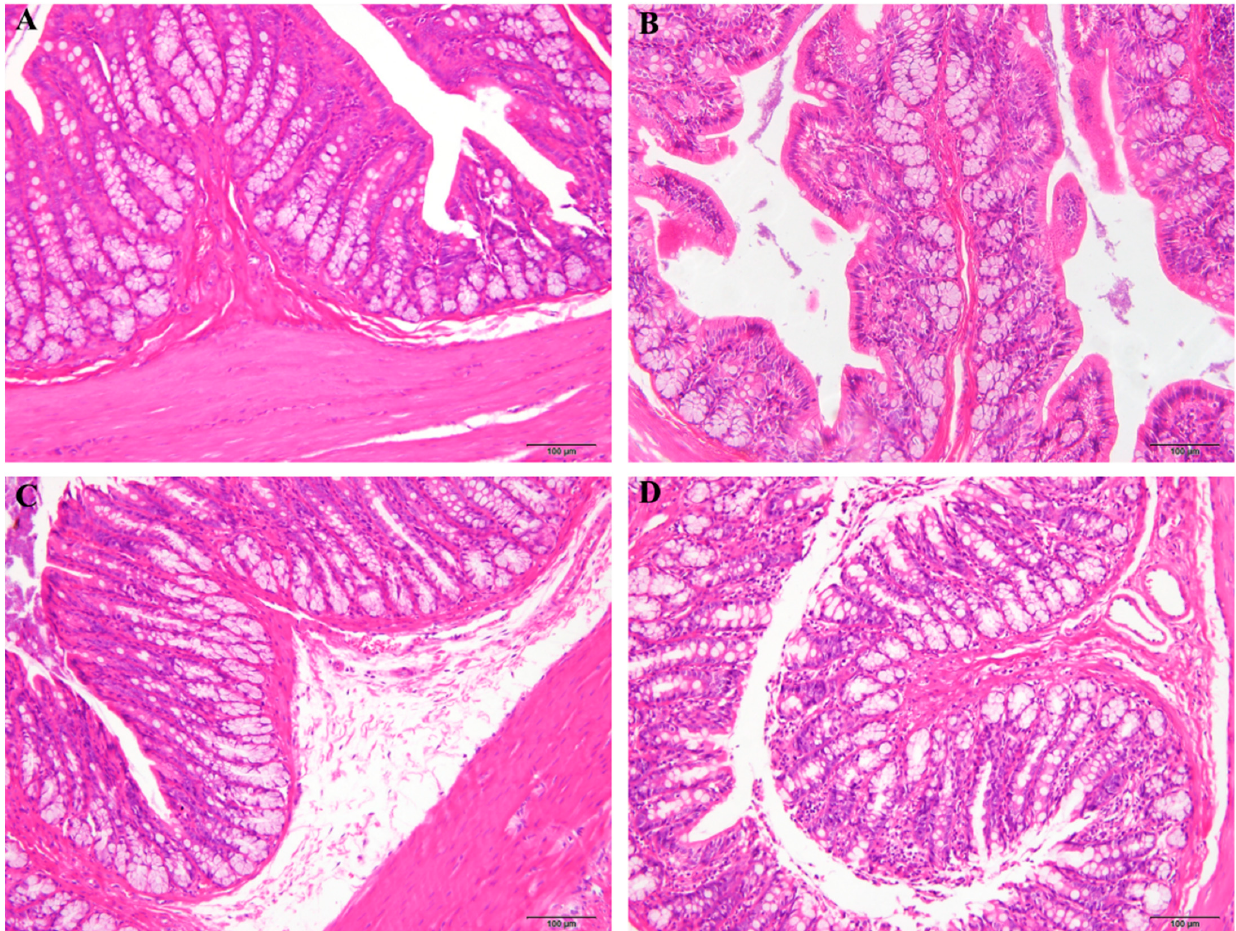
Figure 3. H&E staining to observe the effect of MJGT_EE on the colonic tissues of IBS-C rats (200×). ( A ) The colonic tissues from normal rats; ( B ) the colonic tissues from rats with IBS-C; ( C ) the colonic tissues of IBS-C rats after 30 days of MJGT_EE treatment; ( D ) the colonic tissues of IBS-C rats after 30 days of MSP treatment. ( n = 8 for each group). NC: negative control group; MG: model group, MSP: mosapride group, MJGT_EE: Mao Jian Green Tea ethanol extract group.